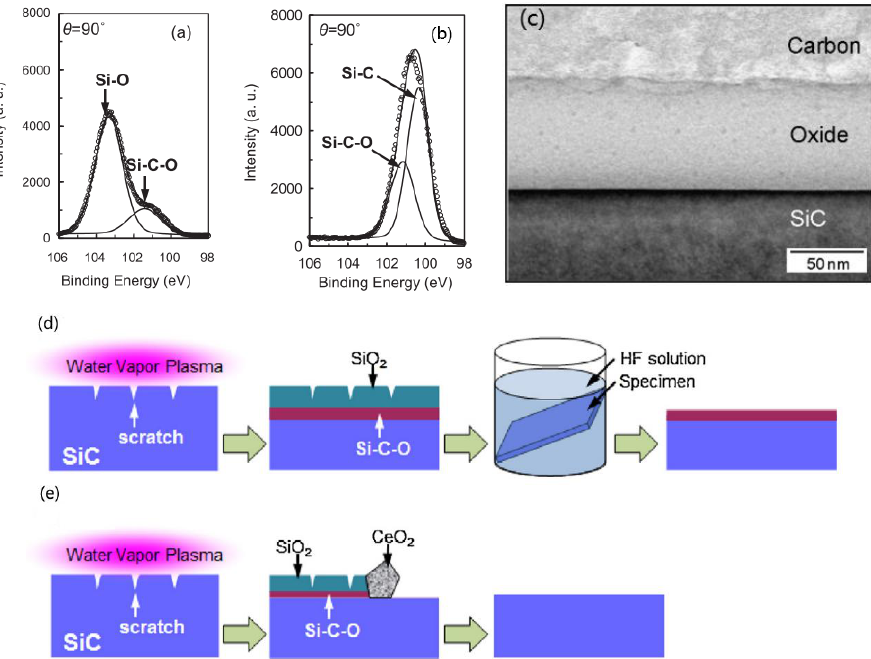
Figure 17. ARXPS spectra (Si2p) of 4H-SiC surface ( a ) by water vapor plasma irradiated, ( b ) the surface in ( a ) after HF dipping, ( c ) XTEM image of a surface irradiated by water vapor plasma for 1 h, probable mechanism of scratch removal ( d ) by plasma oxidation and HF dipping and ( e ) by PAP using ceria abrasives [41].